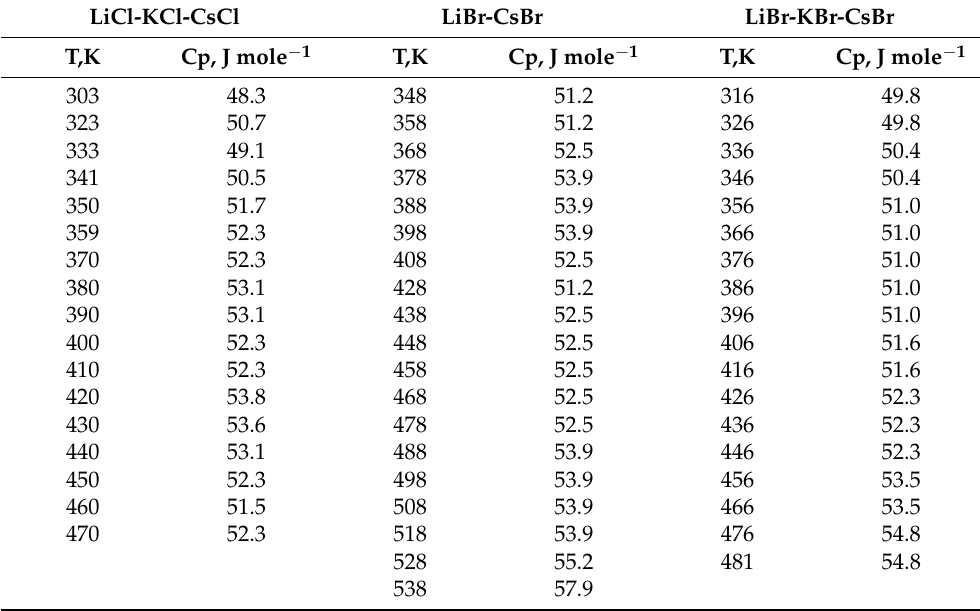
Table 2. Heat capacity of solid